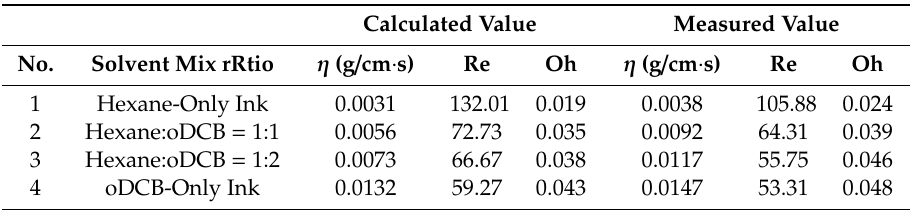
Table 3. Re number and Oh number of the cosolvent inks depending on the mix ratio of hexane and